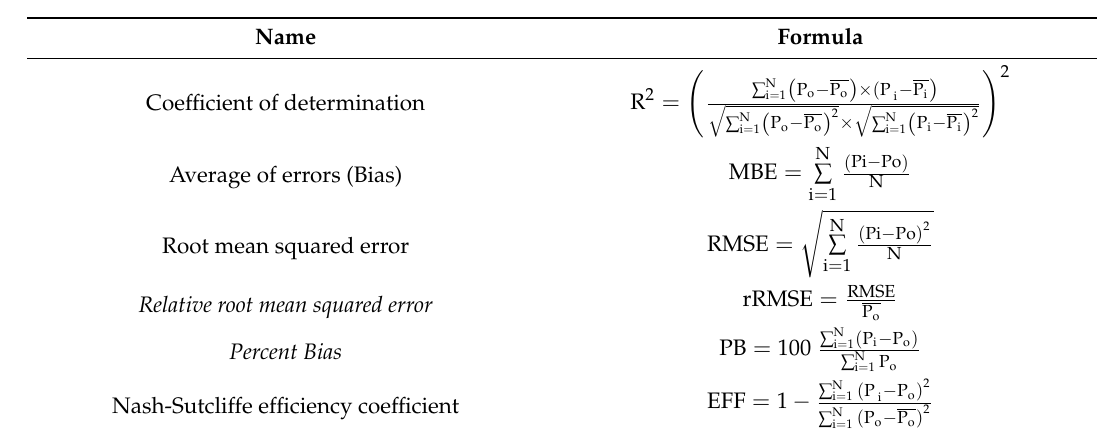
Table 2. Formulas of performance measures coefficient of determination (R 2 ), average of errors (MBE), root mean squared error (RMSE), relative root mean squared error (rRMSE), percent average of errors (PB), and Nash-Sutcliffe efficiency